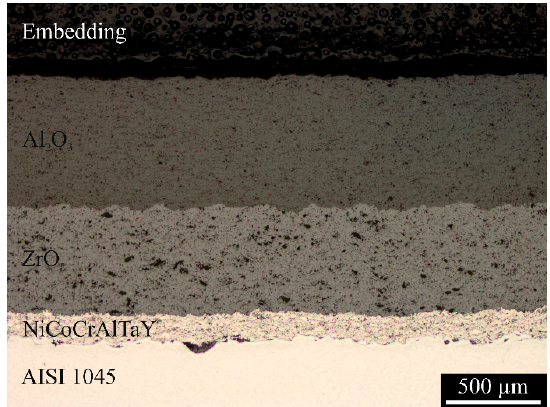
Figure 12. Cross-section of the multilayer design of the thermally sprayed insulating coatings of the ceramic insert.